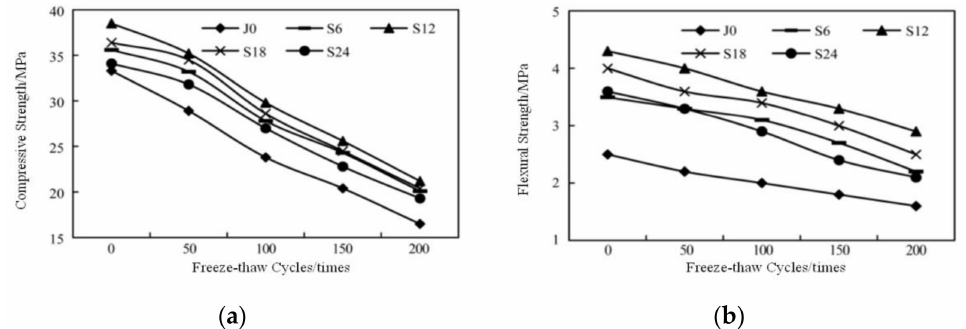
Figure 15. Effect of steel fiber content on the mechanical properties of RAC after freeze–thaw cycles [137]: ( a ) Variation in compressive strength; ( b ) Variation in tensile